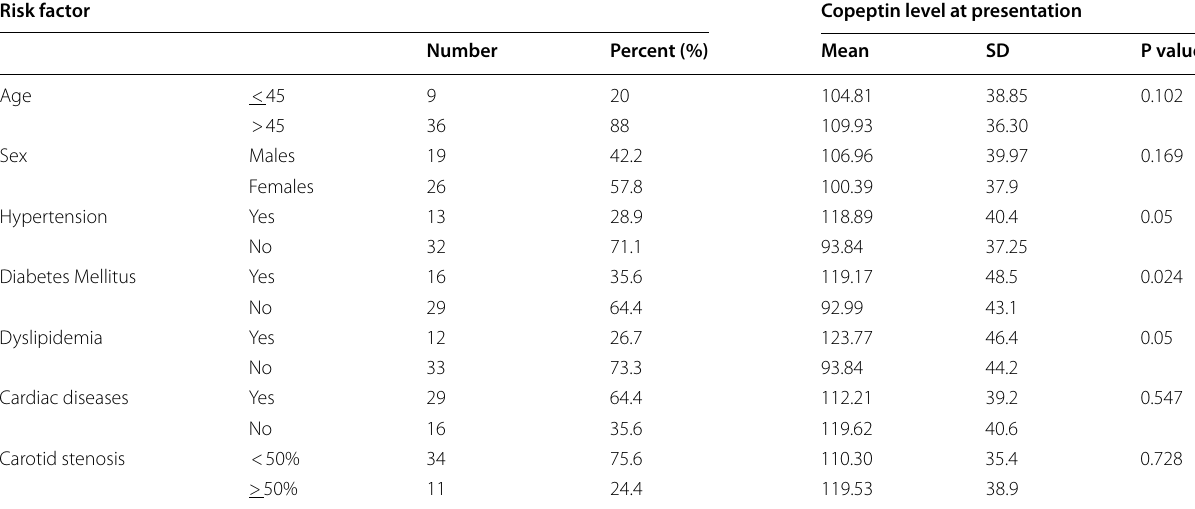
Table 5 The relation between risk factors of stroke and copeptin level at presentation Risk factor